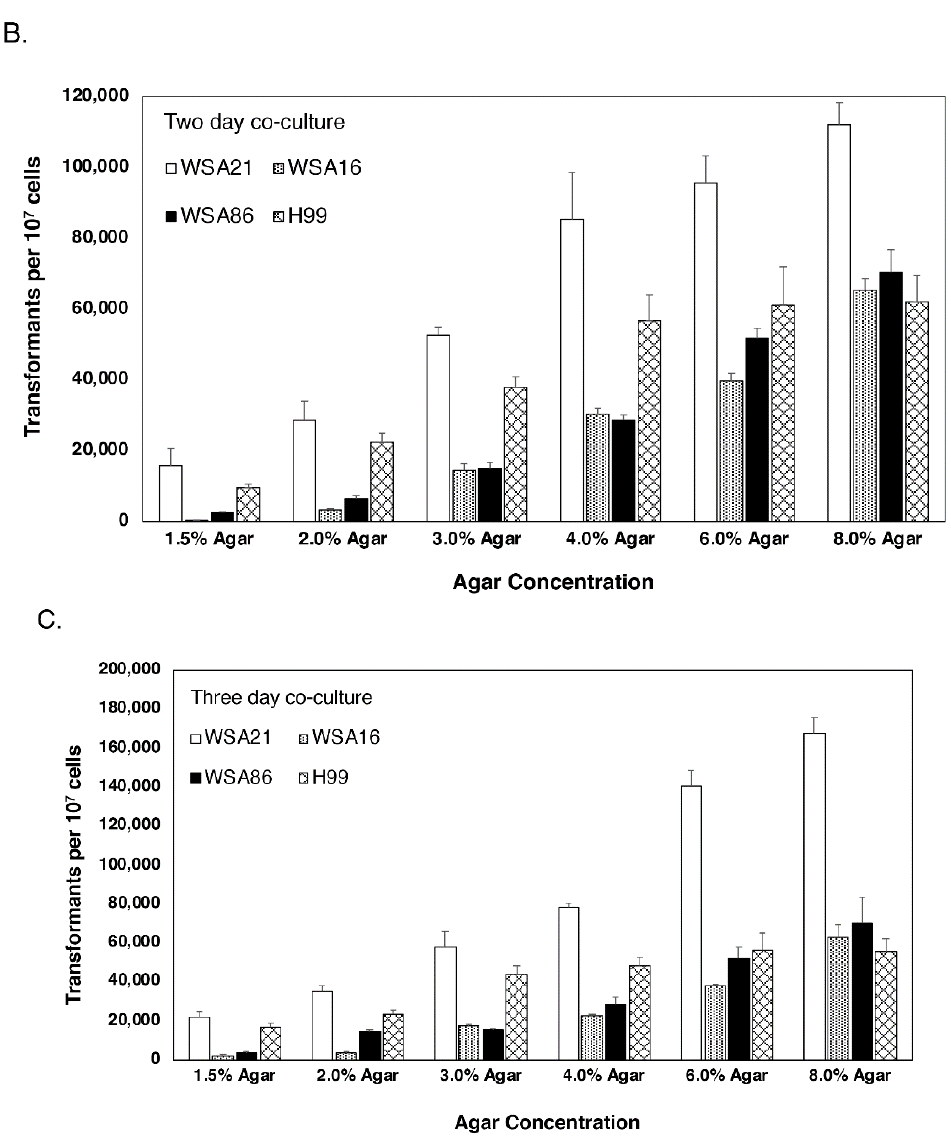
Figure 4. The effect of agar concentration on transformation frequency. For each of the four strains (WSA21, WSA16, WSA86, H99) increasing agar concentration resulted in an increase in transformation frequency. Transformant numbers increased each day, with WSA21 showing the highest number of transformants for each time point. Experiments were performed in triplicate with three plates per experiment. Colony counts are per 1 × 10 7 C. neoformans cells. ( A ) 24 h incubation, ( B ) 48 h incubation, ( C ) 72 h incubation.